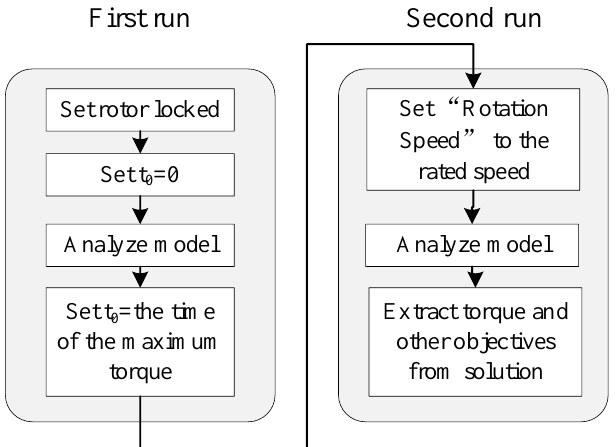
Figure 7. Workflow of two-stage simulation to get the accurate degree of torque angle for symmetric and asymmetric IPMSMs.